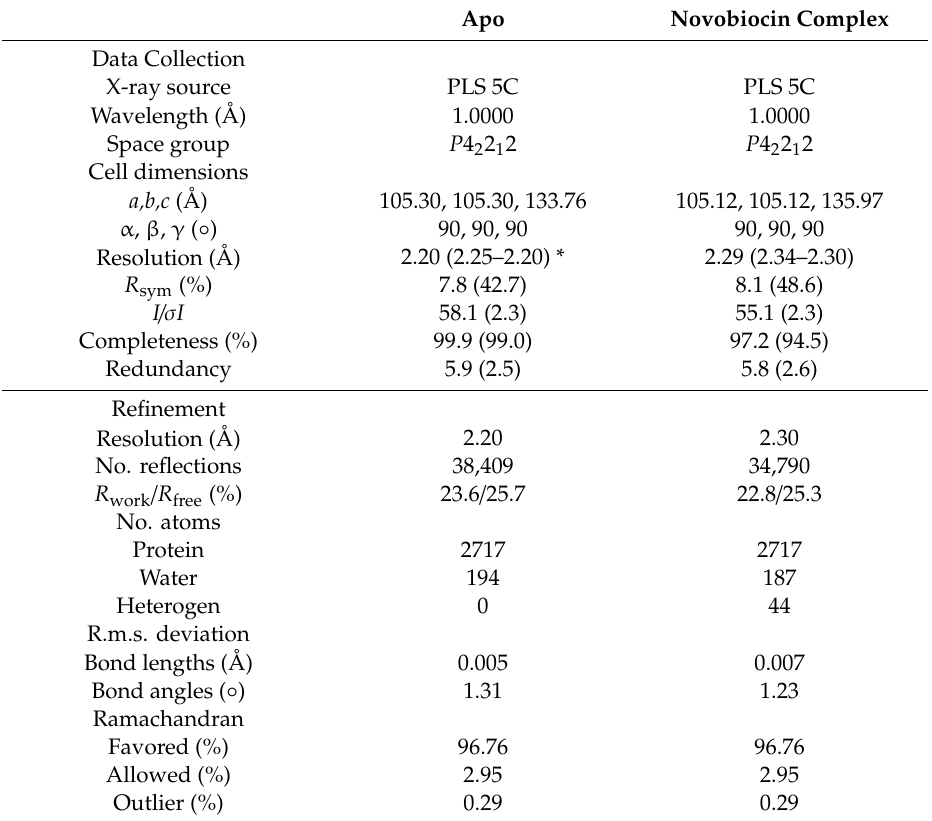
Table 1. The coordinate and structure factors for the apo and novobiocin complex have been deposited in Protein Data Bank (http: // www.rcsb.org) under accession codes 3LNU and 3LPS, respectively. Table 1. Data collection and refinement statistics. Apo Novobiocin